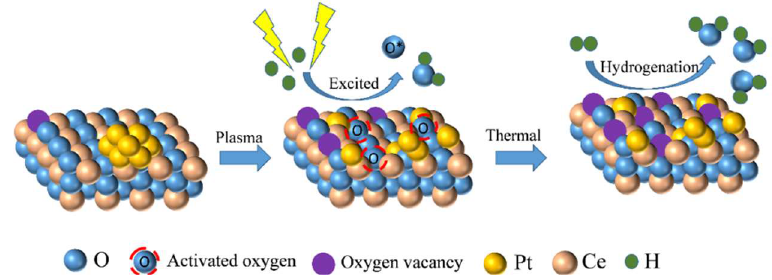
Figure 9. Modification mechanism of PC-PT.